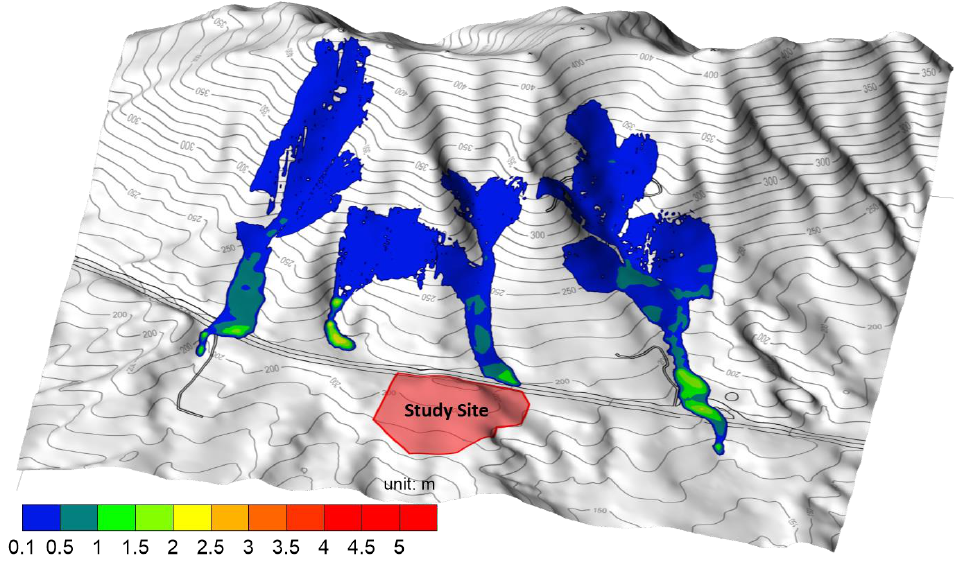
Figure 10. Final deposition area of debris in four watersheds. Color scale means thickness of deposited debris.